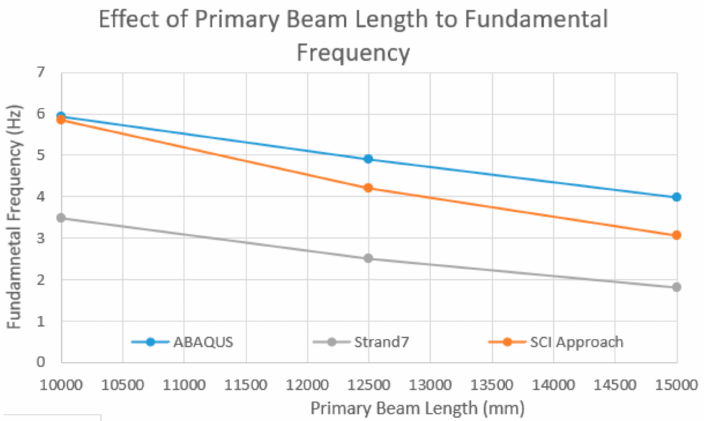
Figure 11. Comparison of the Fundamental Frequency by respecting to the different length of the primary beams.